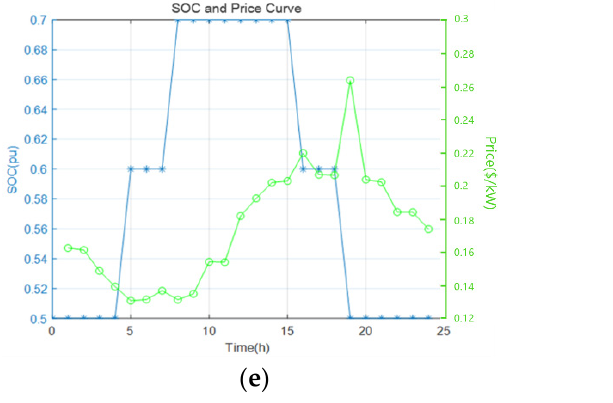
Figure 17. ( a ) SOC graph when life-cycle cost is not considered; ( b ) SOC graph when life-cycle cost weight is 0.1; ( c ) SOC graph when life-cycle cost weight is 0.4; ( d ) SOC graph when life-cycle cost weight is 0.5; ( e ) SOC graph when life-cycle cost weight is 0.6; ( f ) SOC graph when life-cycle cost weight is 0.8.